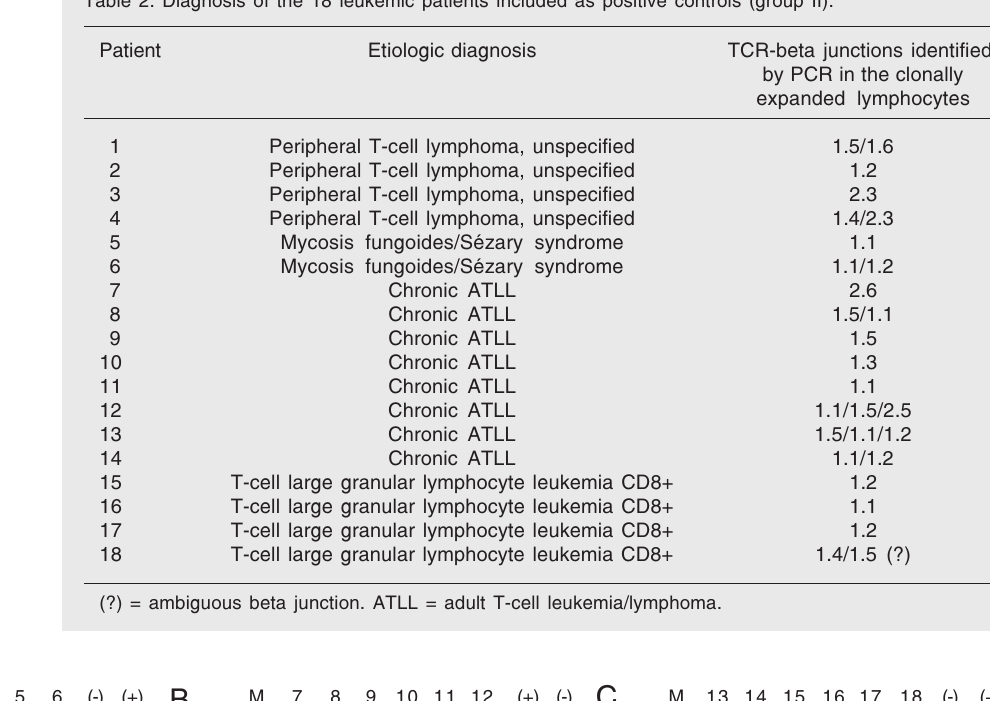
Table 2. Diagnosis of the 18 leukemic patients included as positive controls (group II).